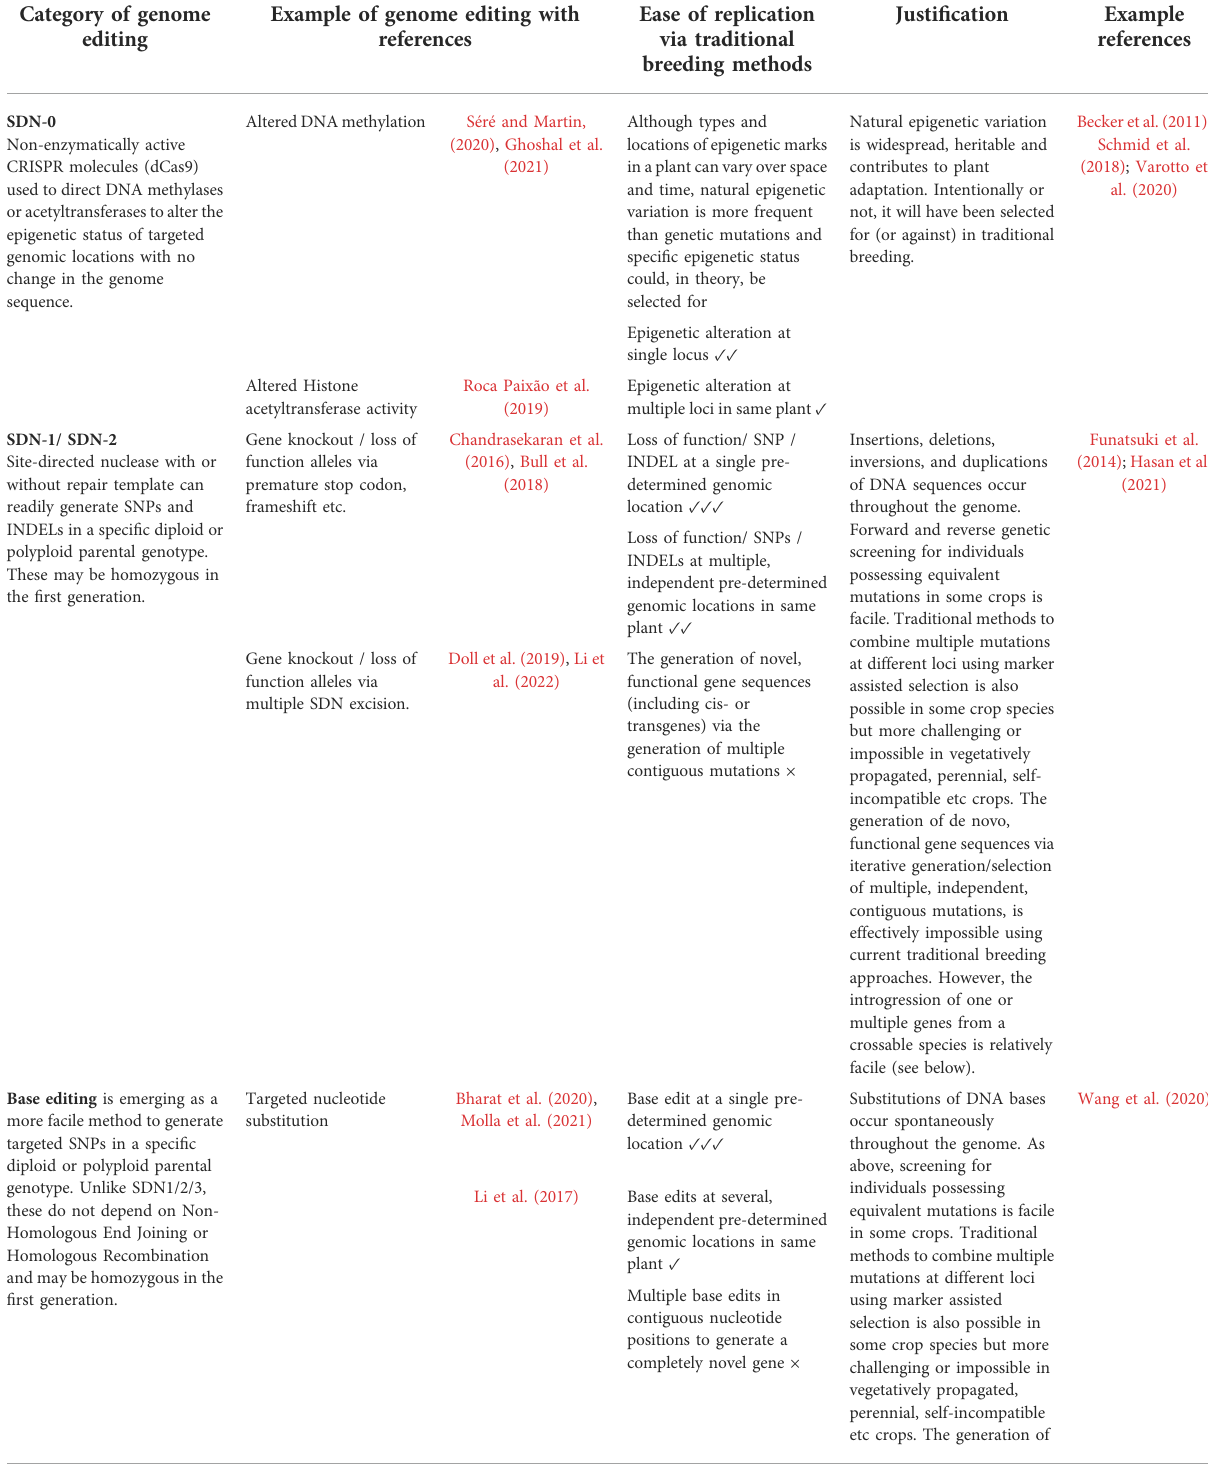
TABLE 1 Applications of genome editing that may or may not be possible to achieve using traditional breeding methods. The level of technical dif fi culty and/or time needed to for different types of genome editing to be replicated using traditional breeding methods are indicated by: ✓✓✓ relatively facile; ✓✓ possible in longer time frames; ✓ technically challenging, laborious or needing much long time frames; × not possible in any reasonable